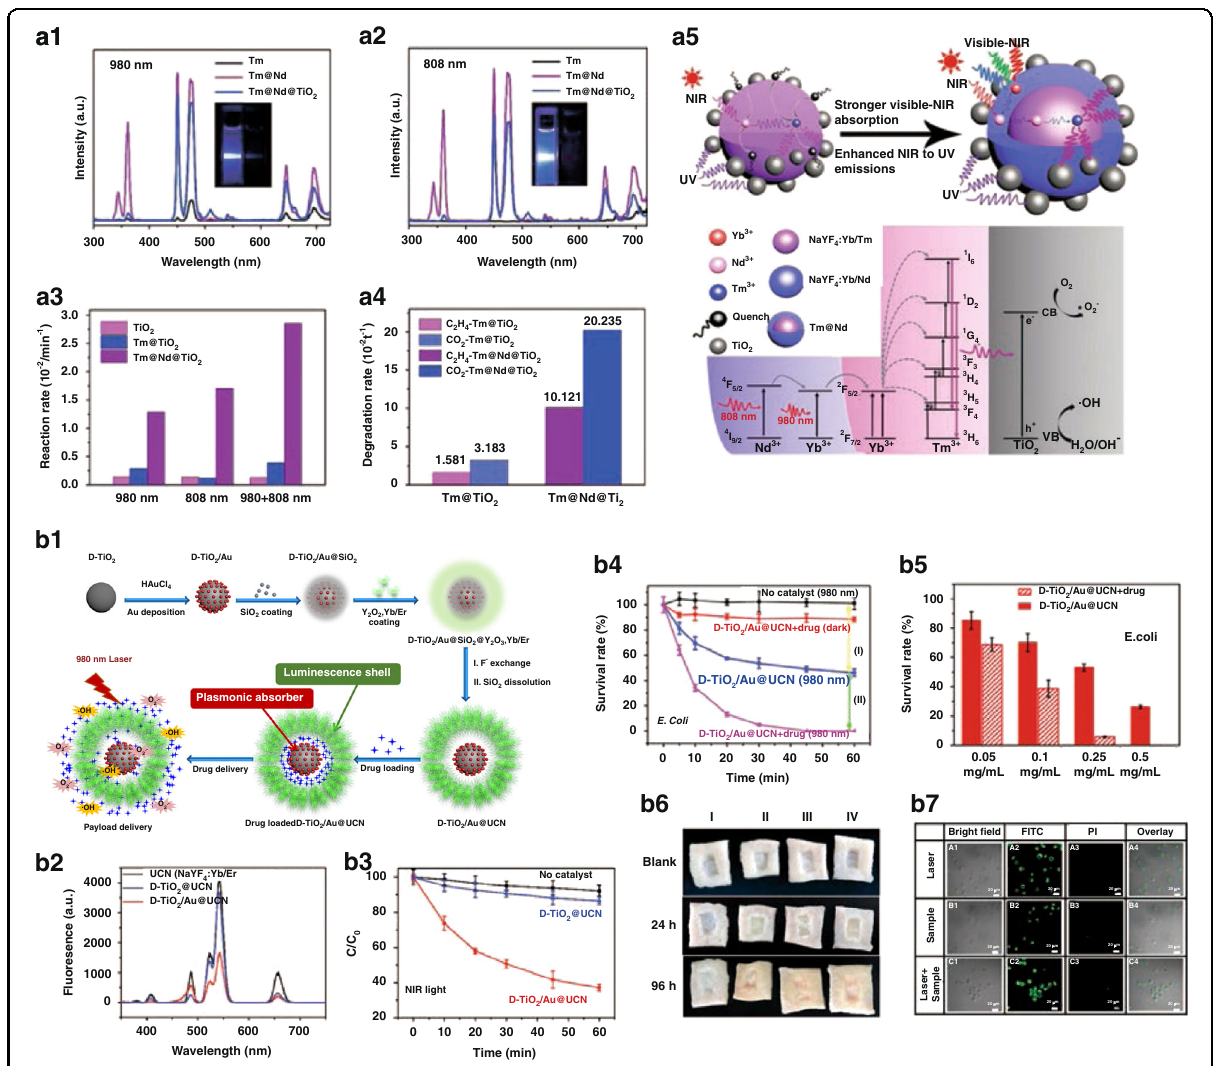
Fig. 10 Photocatalysis. UCL spectra of NaYF 4 :Yb 3 + ,Tm 3 + (Tm), Tm@Nd, and Tm@Nd@TiO 2 under 980 nm excitation ( a1 ) and 808 nm excitation ( a2 ). The insets of a1 and a2 are luminescence photographs of Tm@Nd (left) and NaYF 4 :Yb 3 + ,Tm 3 + (right) with the same concentration dispersed in cyclohexane under 980 and 808 nm excitation, respectively. Insets of a1 and a2 : UCL photographs of Tm@Nd (left) and NaYF 4 :Yb 3 + ,Tm 3 +